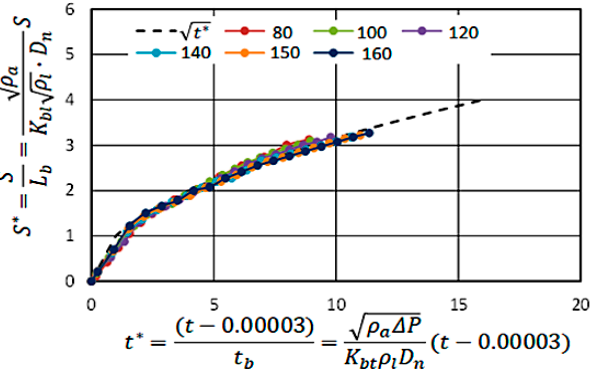
Figure 19. Normalized diesel spray penetration, D n = 0.260 mm, ρ a = 12 kg/m 3 (at 1.0 MPa).